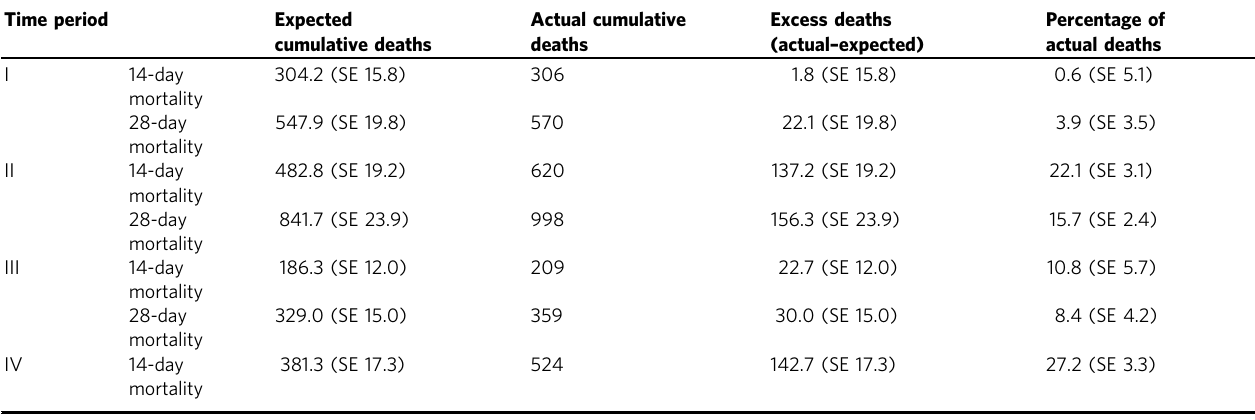
Table 2 Expected versus actual cumulative deaths for 14 and 28 days from the fi rst day of the week of